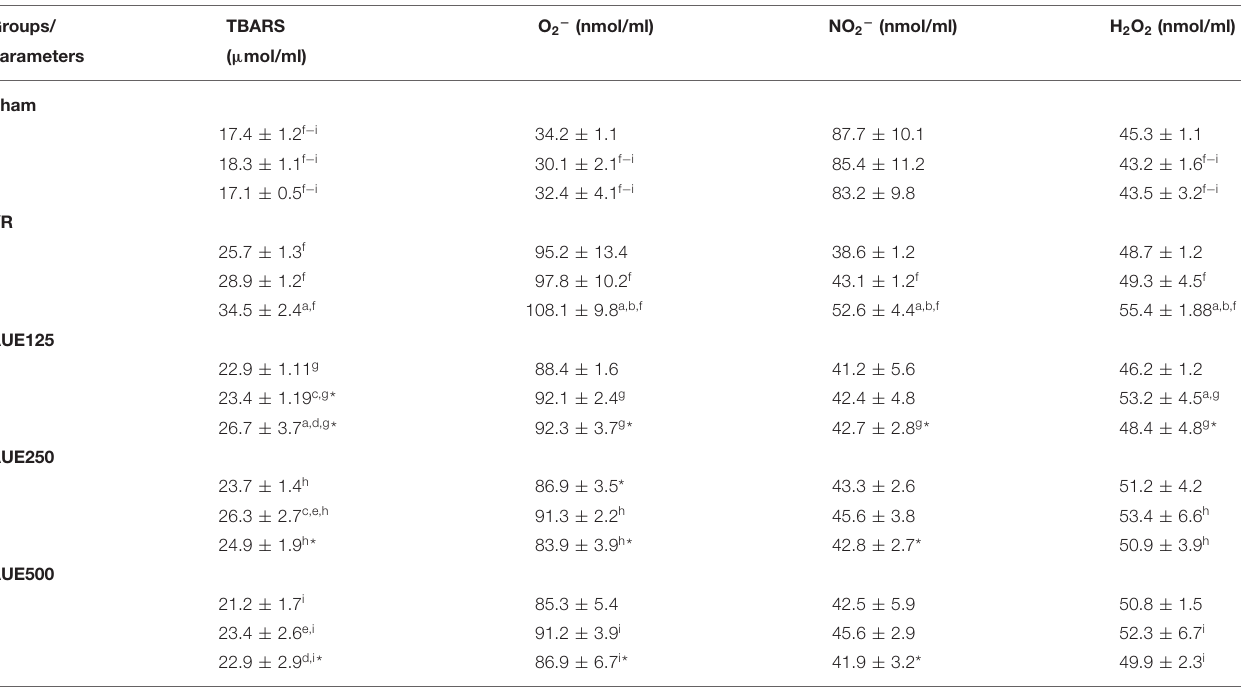
TABLE 2 | Oxidative stress parameters from coronary venous effluent.